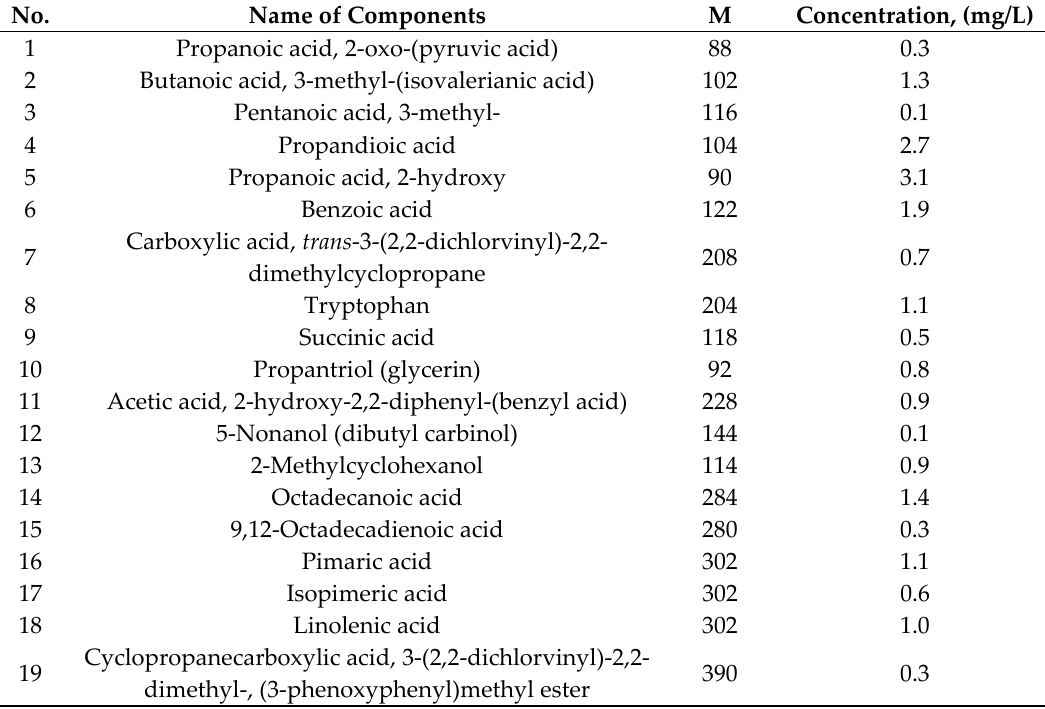
Table 1. The organic compounds from the residual liquor sample.